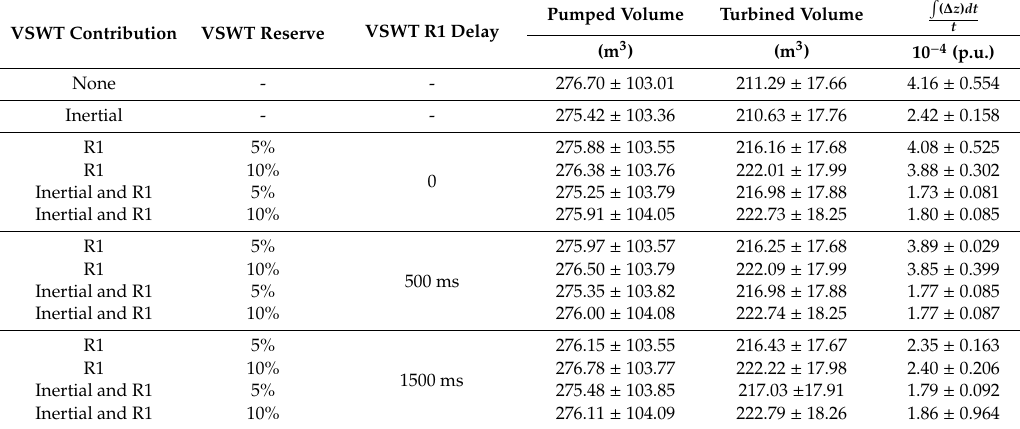
Table 4. Average values of hydraulic parameters considering the proposed VSWT contributions. VSWT Contribution VSWT